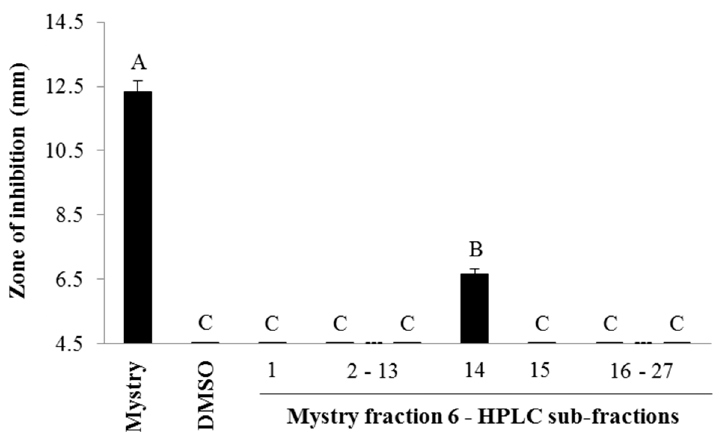
Figure 3. Zones of inhibition of 27 Mystry HPLC sub-fractions of fraction 6 from column chromatography. 2–13, 16–27: fraction 2 through fraction 13 and fraction 16 through fraction 27, respectively. If no inhibition was observed in samples, a value of 4.5 mm, which was the diameter of the wells in agar-well diffusion experiments, was assigned. Means within bars followed by different letters are significantly different ( α = 0.05, ANOVA). Mean ± SEM.